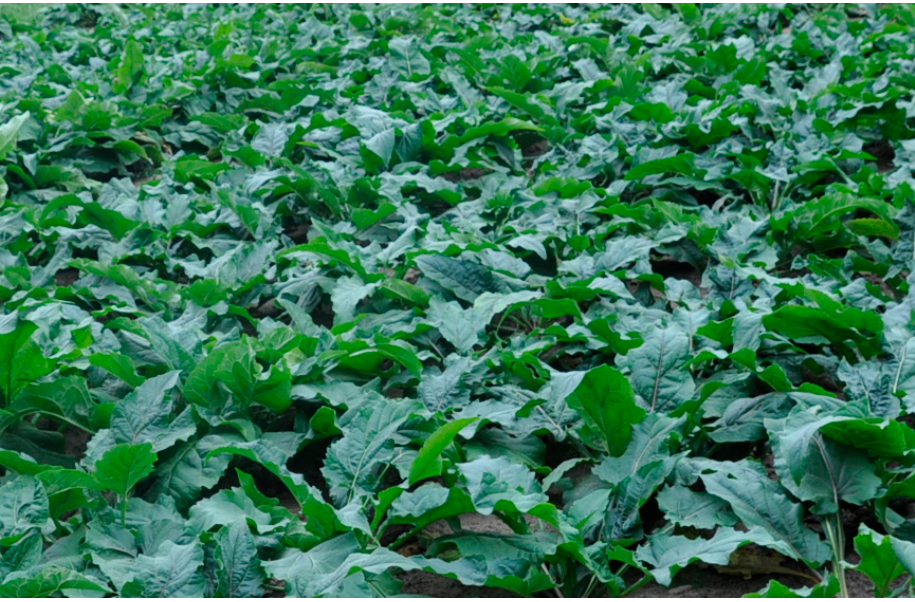
Figure 2. Silphium plants (planting) in autumn 2016—the first year of vegetation. Table 3. Plant number of Silphium per 1 m 2 , depending on methods of plantation establishment. Method of Plantation Establishment Year Mean HSD 0.051 Seeds Planting